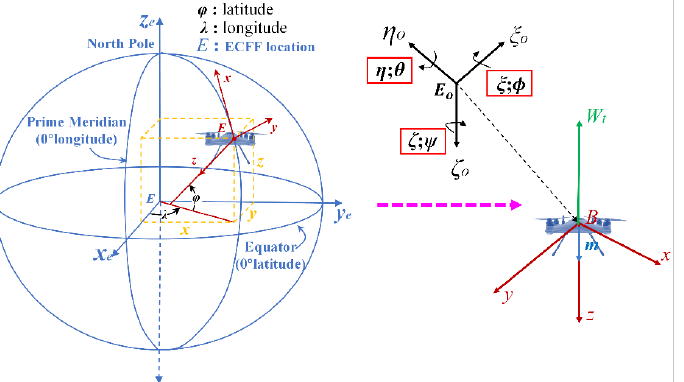
Figure 1. The coordinate frames of the quadrotor.